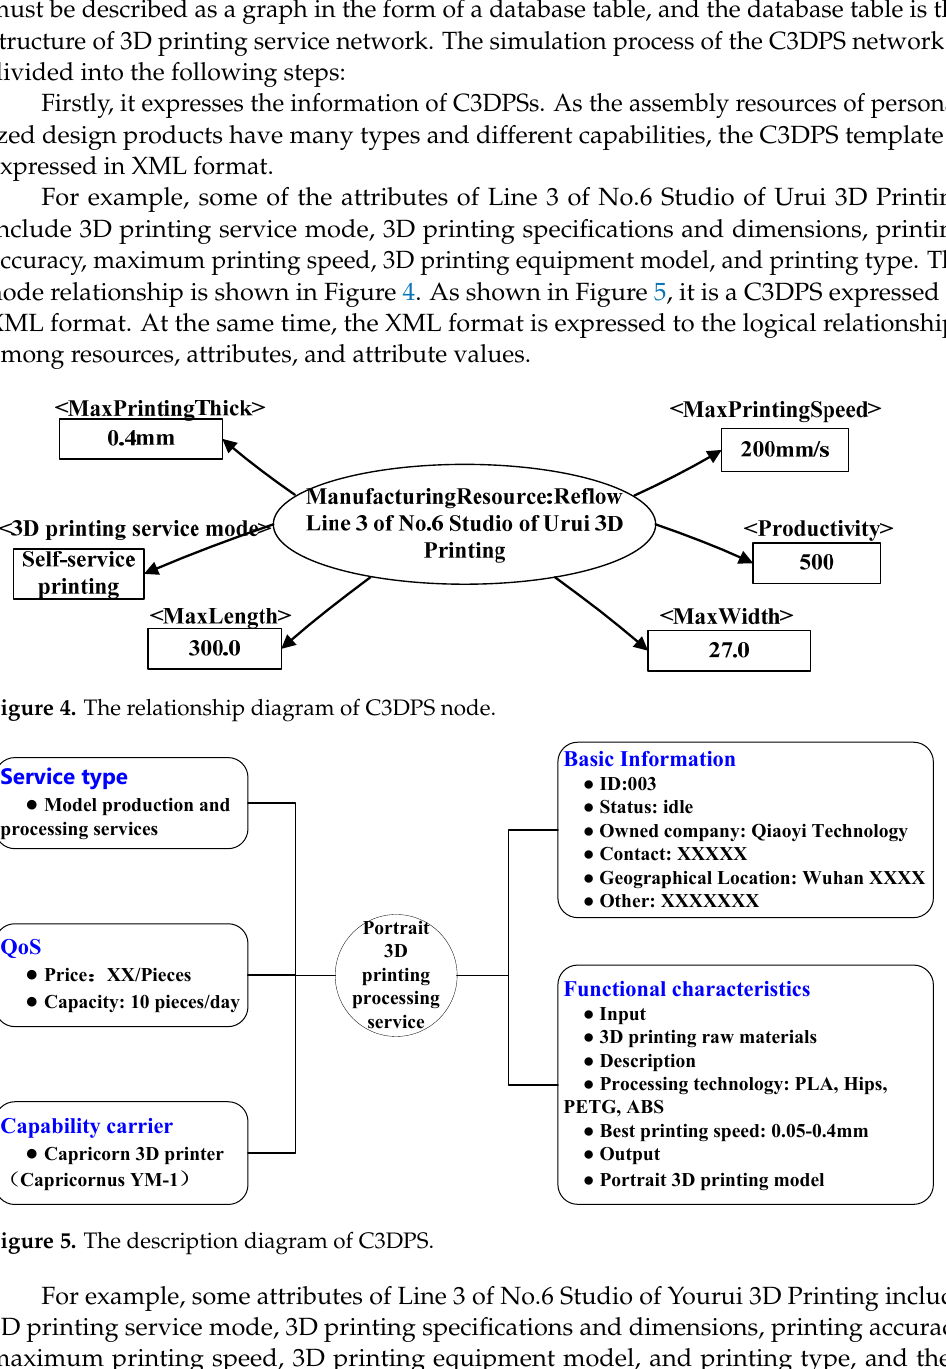
Figure 6. The Partial XML information graph of C3DPS template Secondly, it determines the service node. Here, as the research object, 10 C3DPS pro- viders is selected and established to the basic information table of the node, as shown in Table 2.